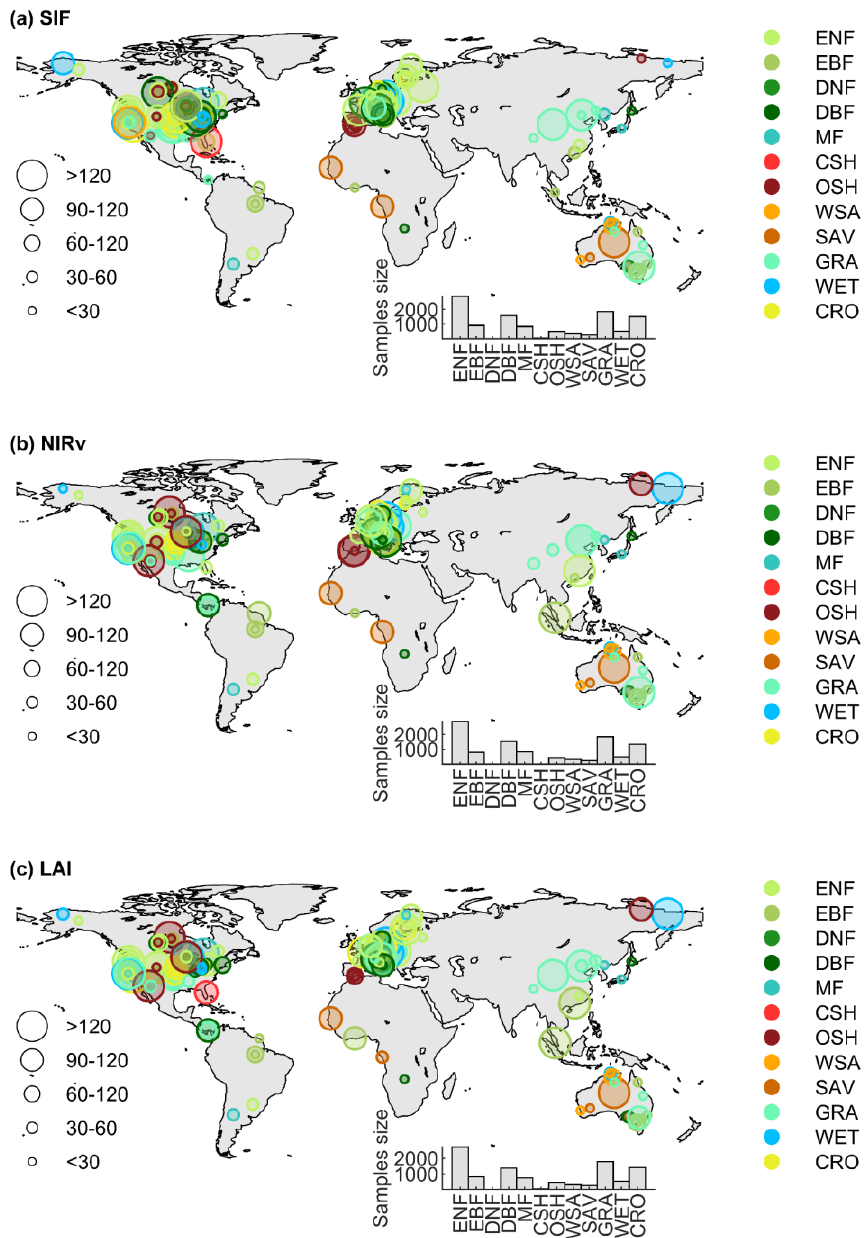
Figure 1. Map of the sites in the FLUXNET2015 dataset used for the models based on each vegetation characteristic parameter. All sites were classified into 12 PFTs according to the IGBP classification scheme. The size of the circles represents the number of samples available at the site. The histogram represents the number of samples for different PFTs. ENF: evergreen needleleaf forests, EBF: evergreen broadleaf forests, DNF: deciduous needleleaf forests, DBF: deciduous broadleaf forests, MF: mixed forests, OSH: open shrublands, WSA: woody savannas, SAV: savannas, GRA: grasslands, CRO: croplands, WET: wetlands.